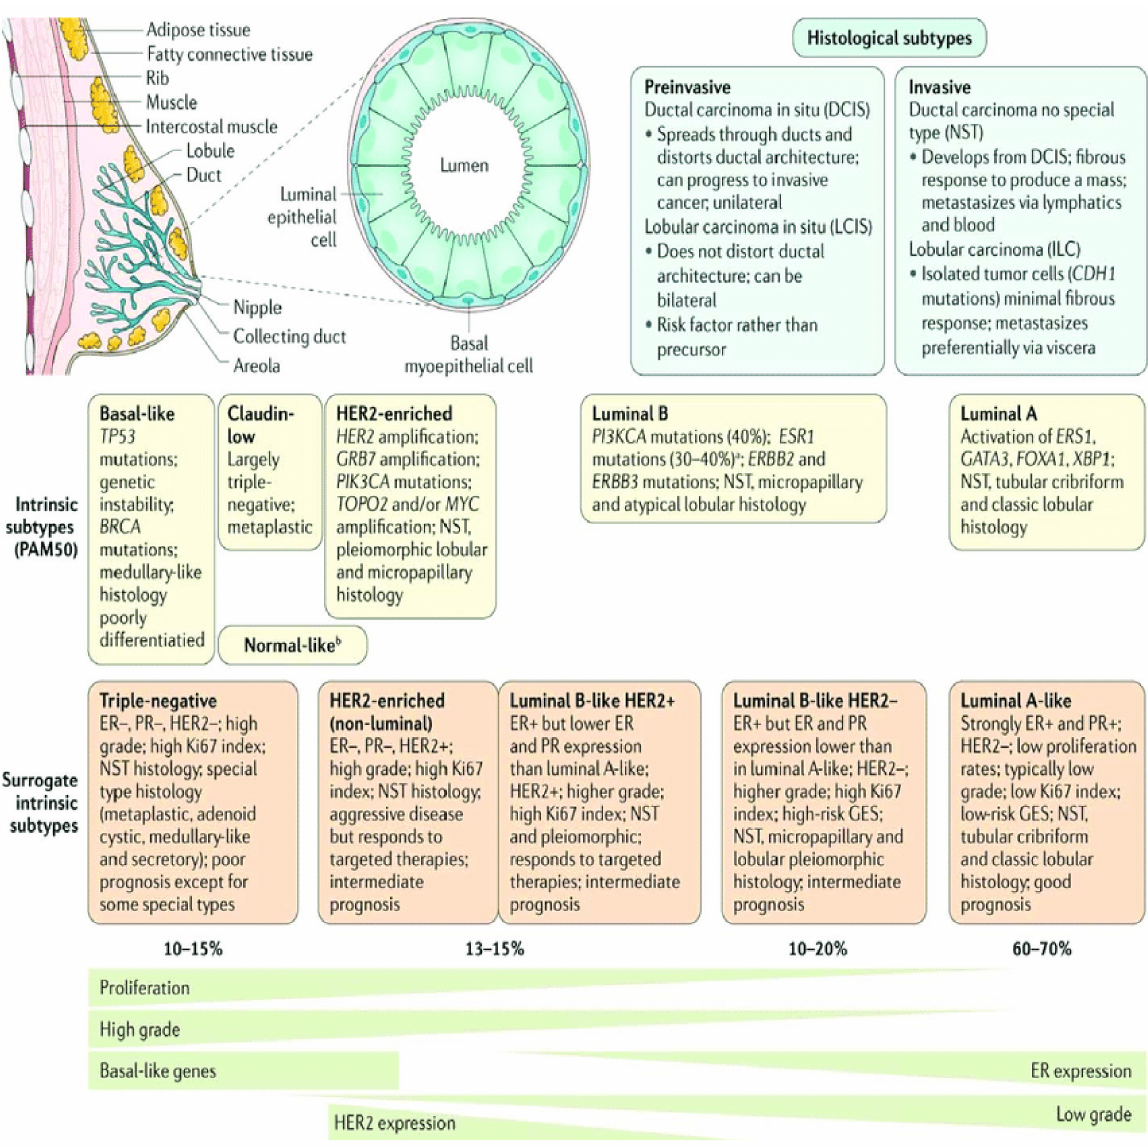
Figure 1. Breast cancer classification [2]. Histological and molecular characteristics of breast cancer have important implications for cancer therapy. Hence, several classifications based on molecular and histological characteristics are developed. The histological subtypes of breast cancer (top right) are the most frequent subtypes, including ductal carcinoma and lobular carcinoma, which are the invasive lesions, while their prevalent counterparts are ductal carcinoma in situ and lobular carcinoma in situ. Intrinsic subtype classification by Perou and Sorlie is based on a 50-gene expression signature (PAM50). The surrogate intrinsic subtype classification of breast cancer is used clinically, and it is based on immunohistochemistry and histology expression of key proteins, including progesterone receptor (PR), estrogen receptor (ER), human epidermal growth factor receptor 2 (HER2), as well as proliferation marker Ki67. Breast cancer tumors expressing ER and/or PR are “hormone receptor-positive”. Tumors lacking ER, PR but showing expression of HER2 are termed as “HER2 positive breast cancer”, while tumors lacking ER, PR, and HER2 are called “triple- negative breast cancer”